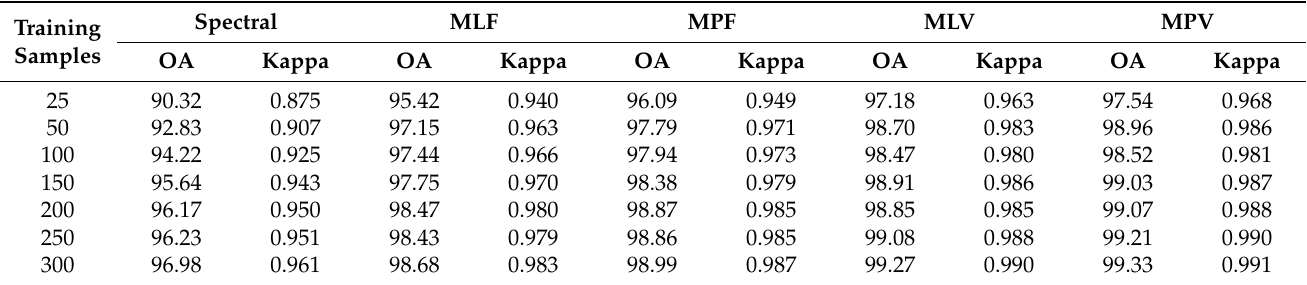
Table 4. OAs (%) and Kappa coefficients obtained by different methods for the Longkou dataset using SVM with different numbers of training samples per class.